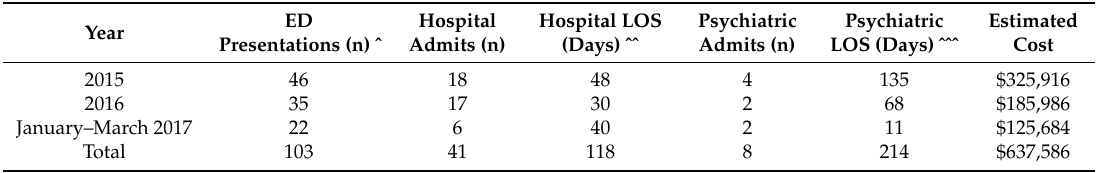
Table 3. Case 3: Hospital presentations and admissions (January 2015–March